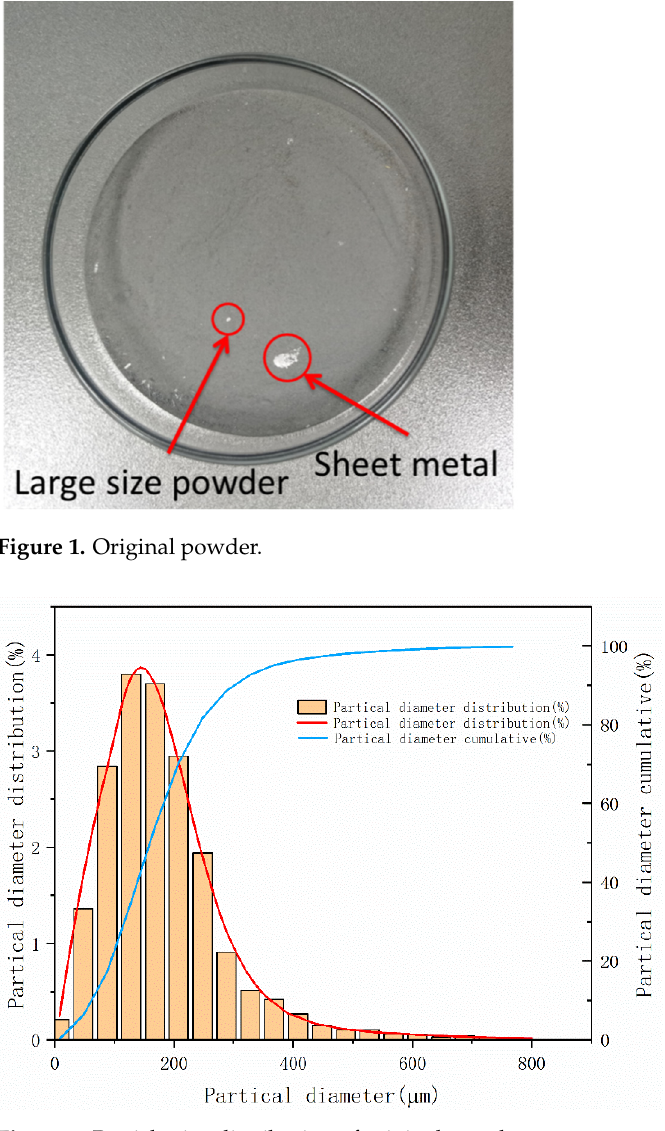
Figure 2. Particle size distribution of original